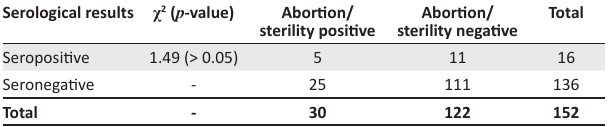
TABLE 4: Relationship between animals with history of abortion/sterility and brucellosis as measured by competitive enzyme-linked immunosorbent assay amongst the transhumant and sedentary cattle populations screened in Yewa Division,